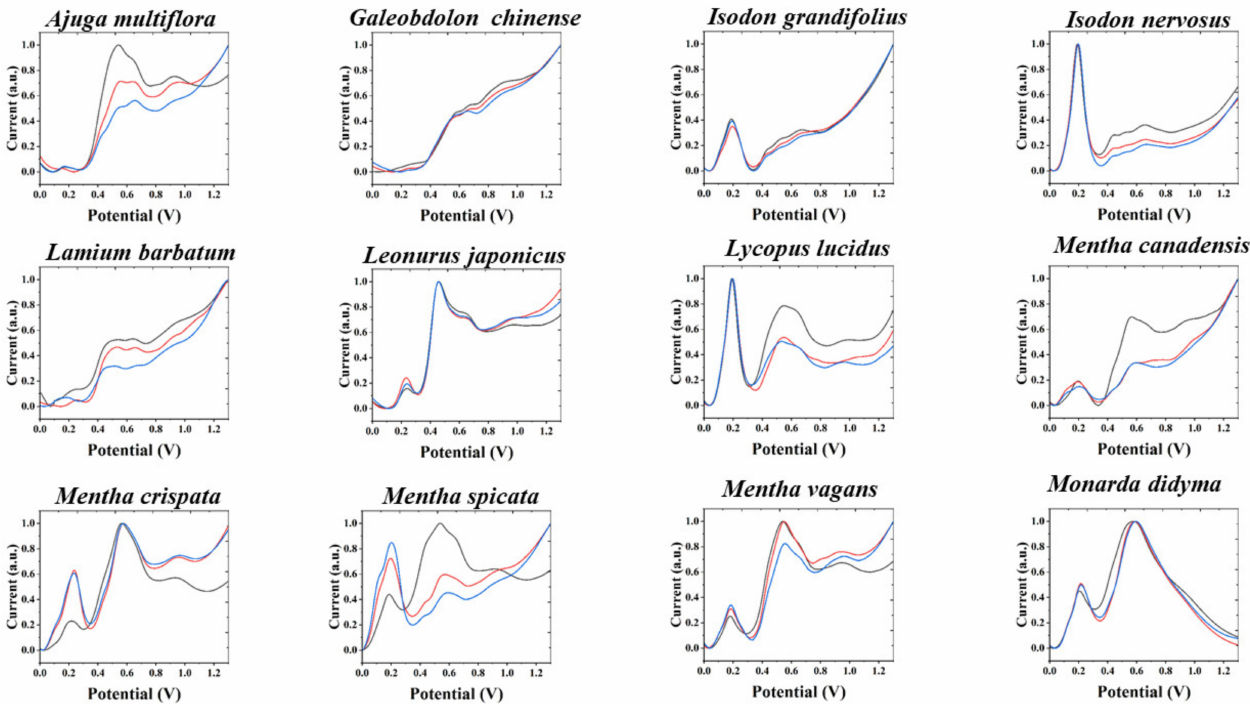
Figure 2. Electrochemical fingerprint of 12 species of Lamiaceae after ethanol extraction and recorded under ABS condition (the remaining 24 species can be found in the Supplementary